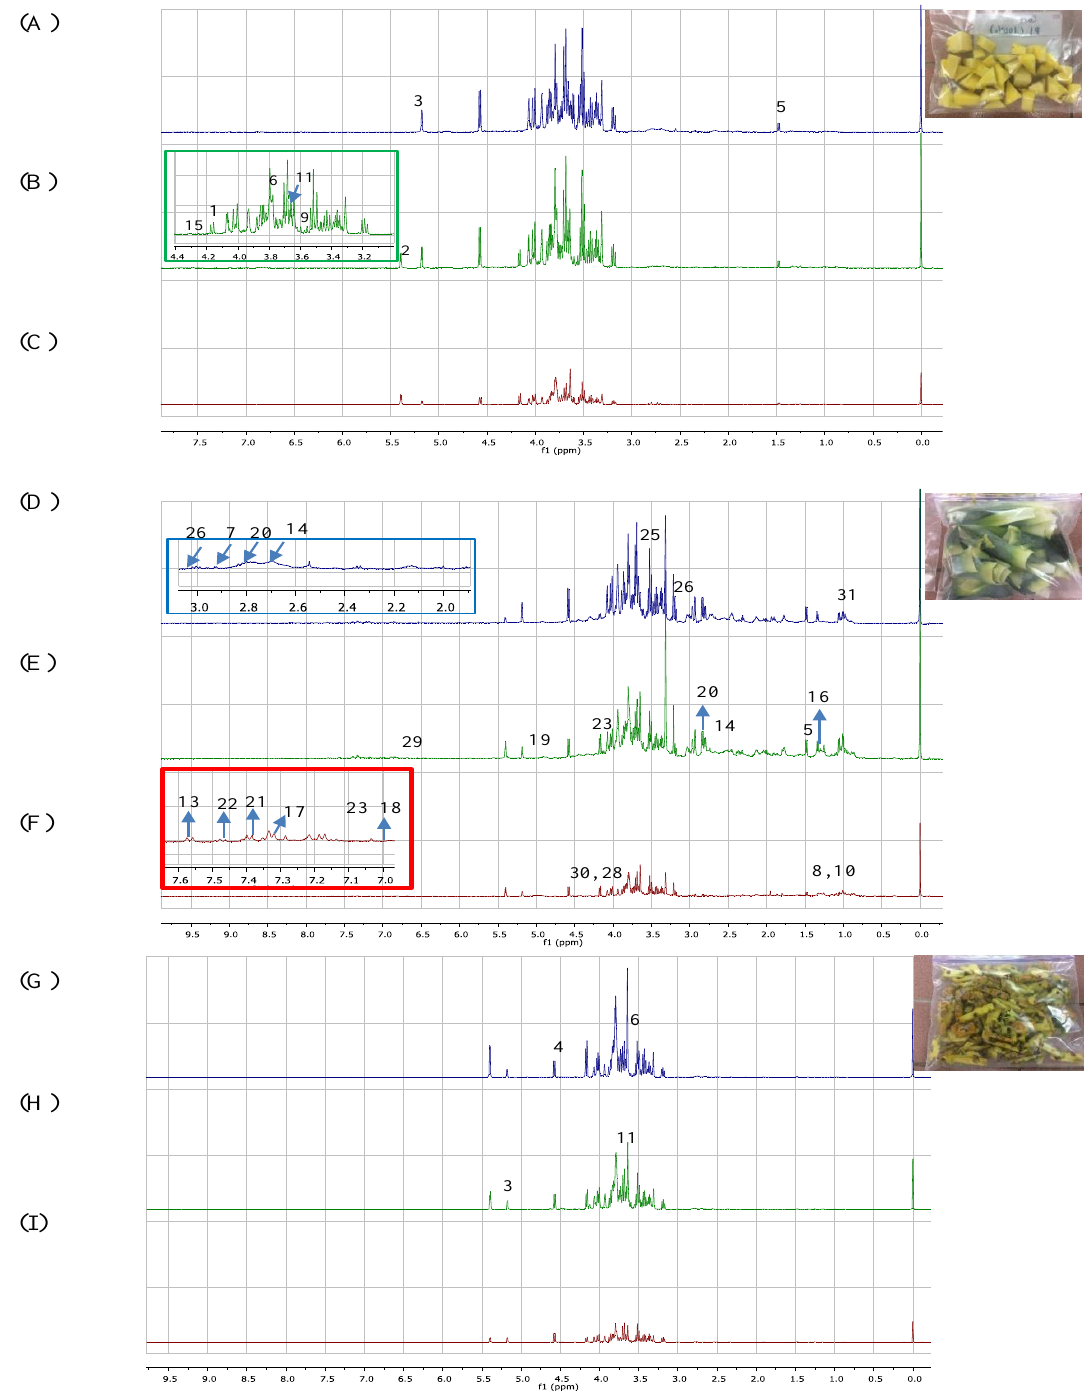
Figure 2. 500MHz representative 1H NMR spectra of MD2 pineapple peel, crown and core extracted with 0, 50 and 100% ethanol ratio. (A) 0% ethanol peel; (B) 50% ethanol peel; (C) 100% ethanol peel; (D) 0% ethanol crown; (E) 50% ethanol crown; (F) 100% ethanol crown; (G) 0% ethanol core; (H) 50% ethanol core and (I) 100% ethanol core. See Table 1 for the assignments of the identified metabolites signals.